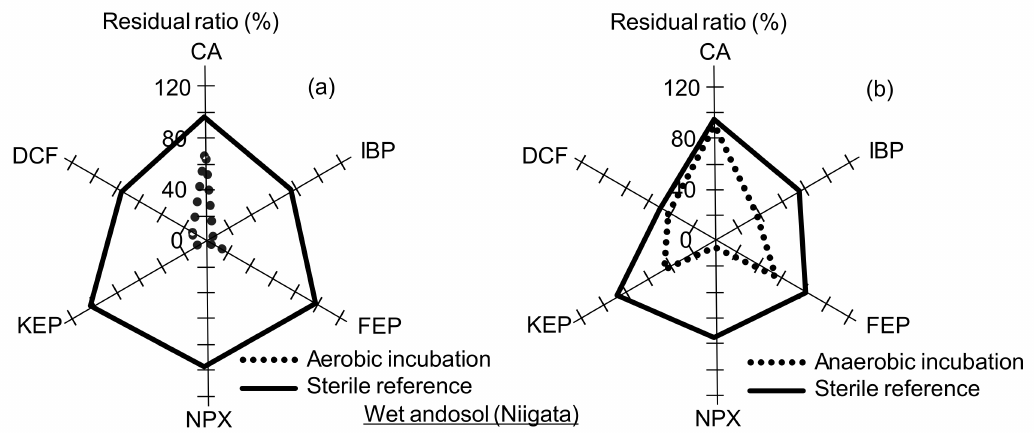
Figure 5. Residual ratios of the pharmaceuticals in wet andosol slurry (Niigata) after 14 days of incubation under aerobic ( a ) and anaerobic ( b )